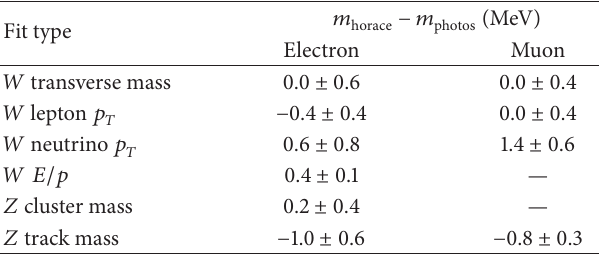
Table 1: Difference between horace and photos pseudodata in fitted masses. The shift in the dimensionless 𝐸/𝑝 value has been multiplied by 80 GeV to convert to the equivalent shift in the fitted 𝑊 boson mass. Templates were made using photos. The statistical errorsareshown.Thetemplatesandpseudodatause10billionevents at the generator level as the input to the detector simulation.